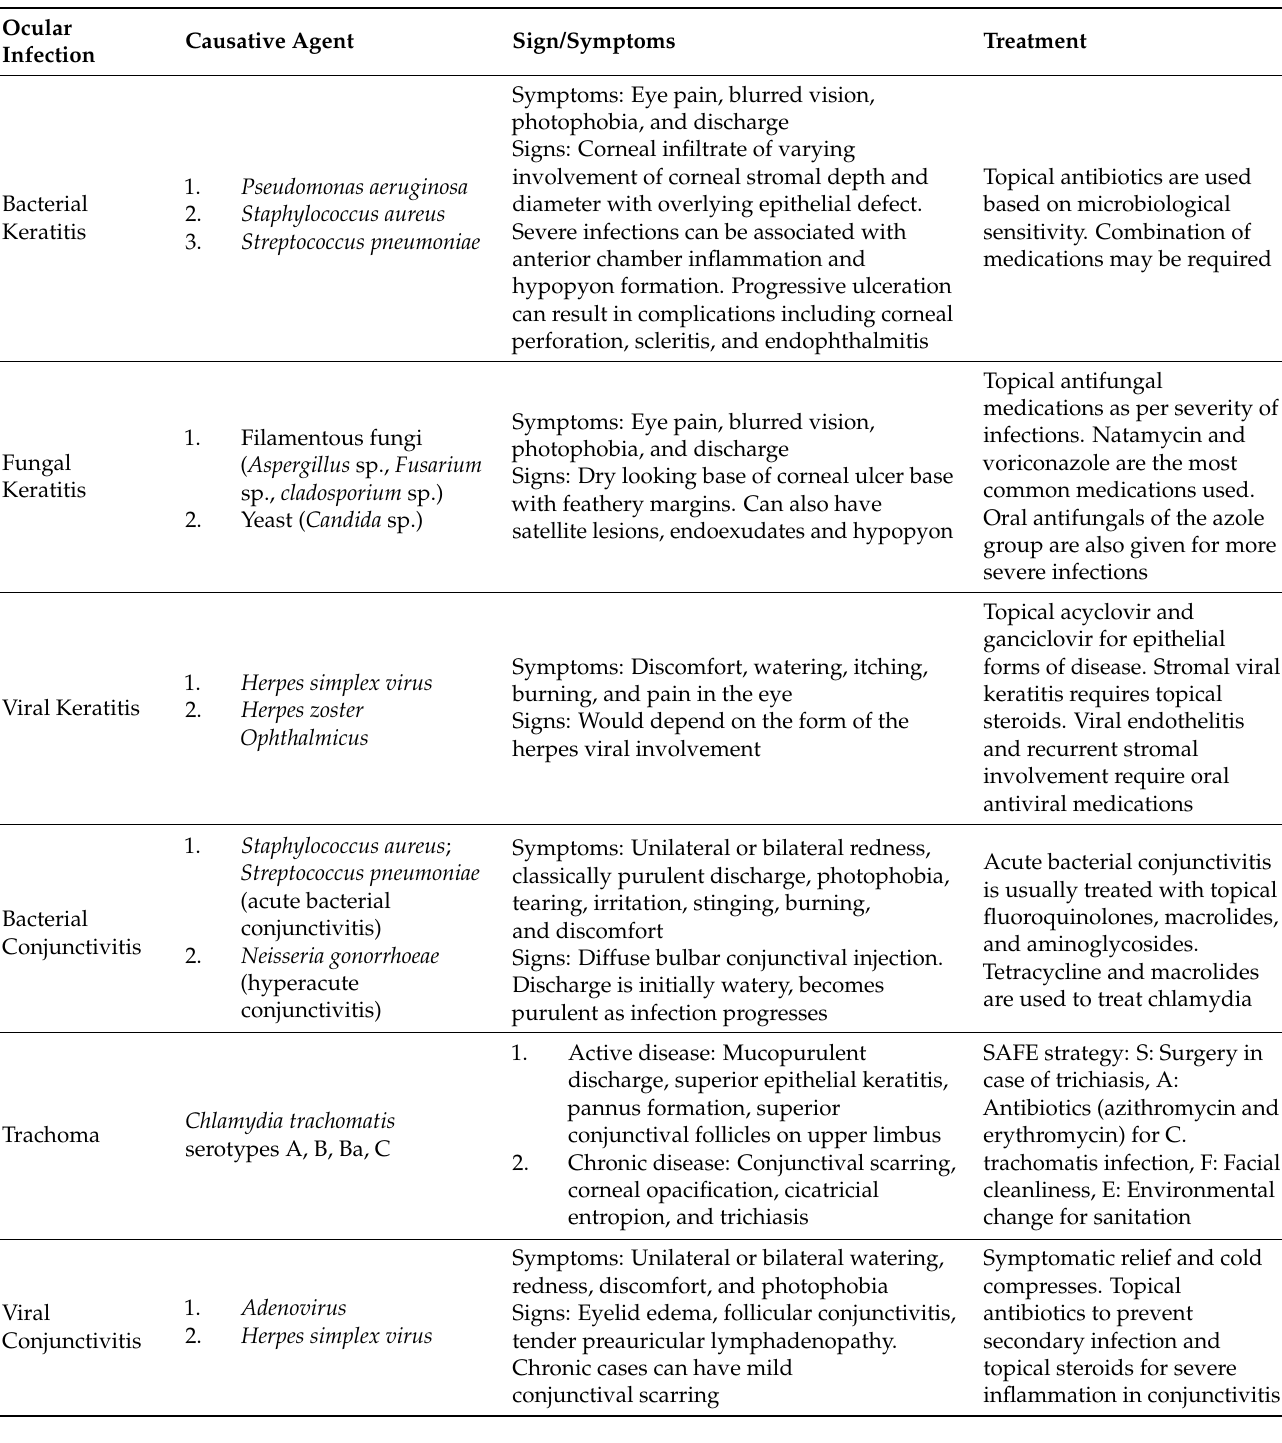
Table 1. Types of ocular infections and their